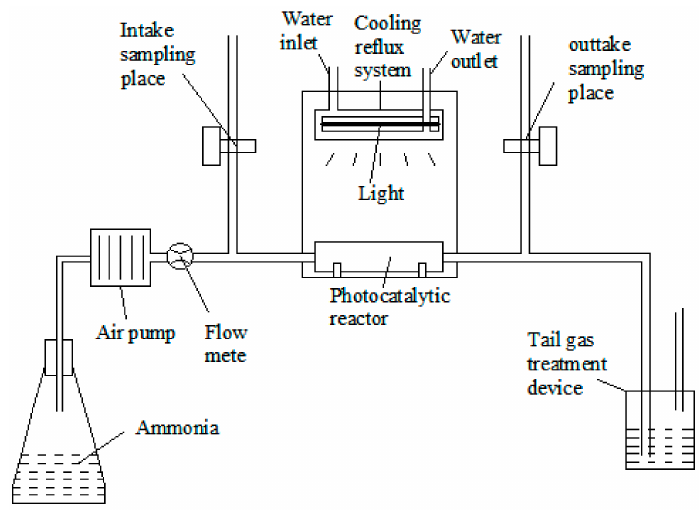
Figure 12. The flow chart of photocatalytic